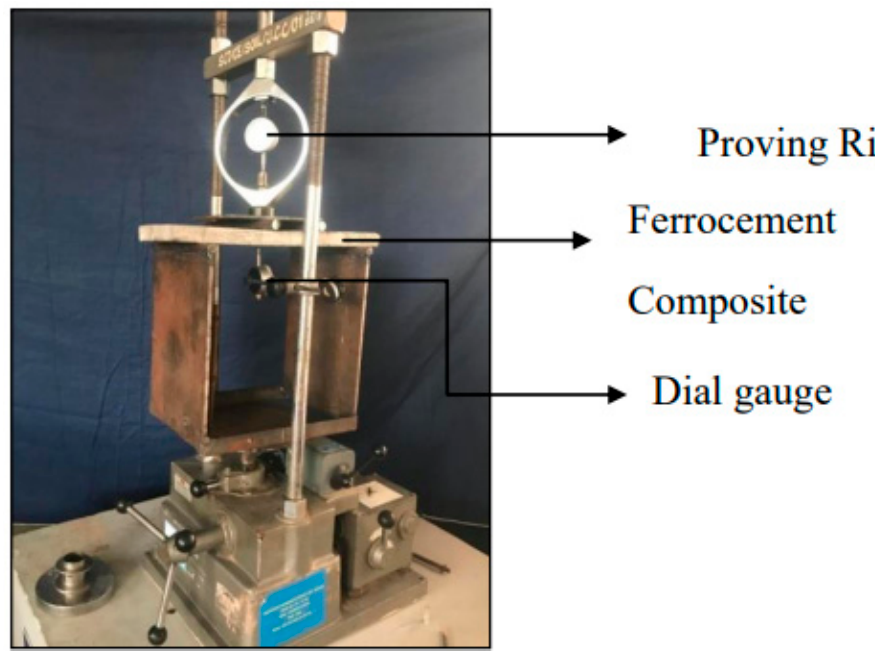
Figure 5. Flexural test set up.